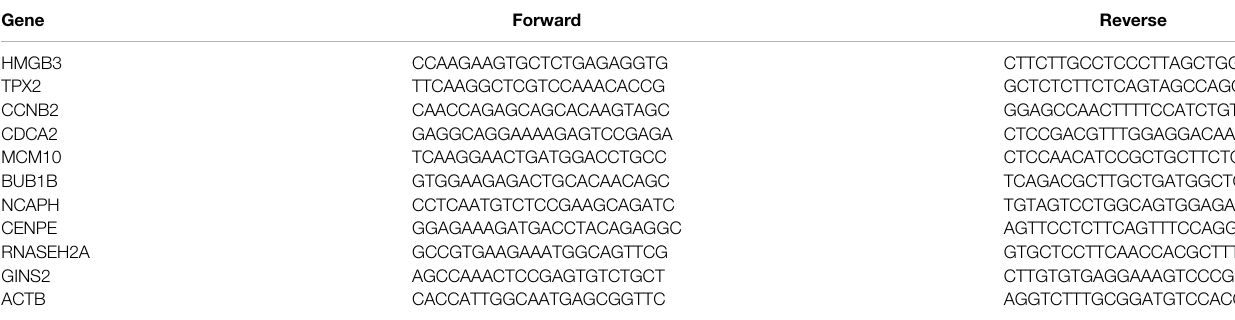
TABLE 1 | Primer sequences used for